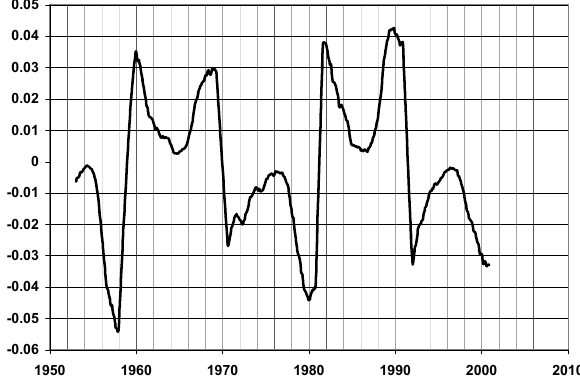
Fig. 2. Drift effect according to the third approach for A dr =2% (at W =75).